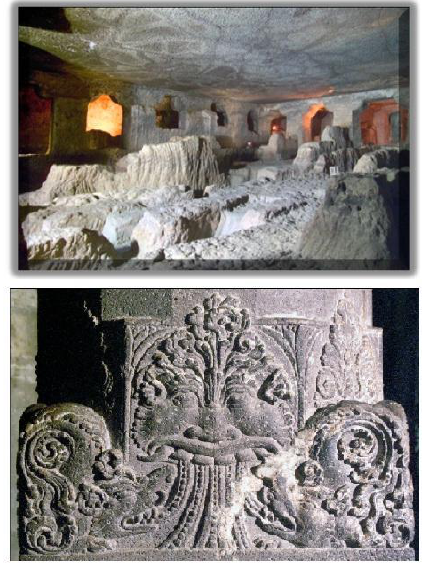
Figure 13. General view of unfinished cave 24 and later ornamentation of Ajanta Pillars based on Bagh caves